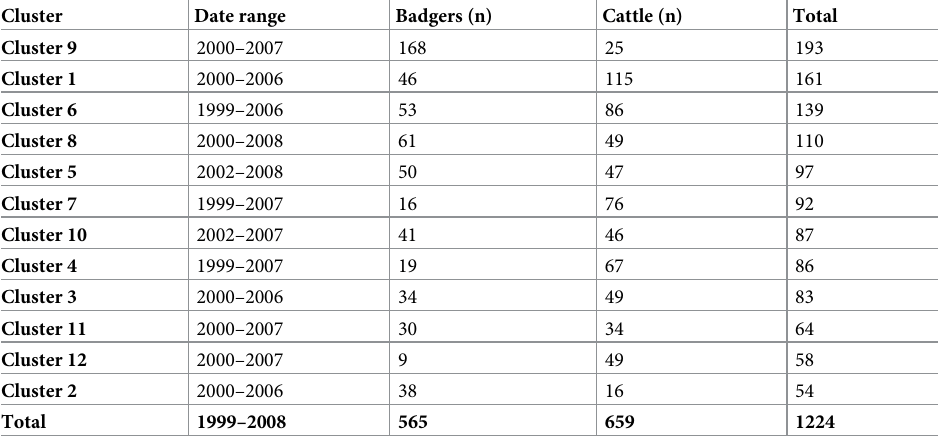
Table 2. Breakdown of the 12 putative transmission clusters by date range and host. The table is ordered by total number of isolates from high to low.